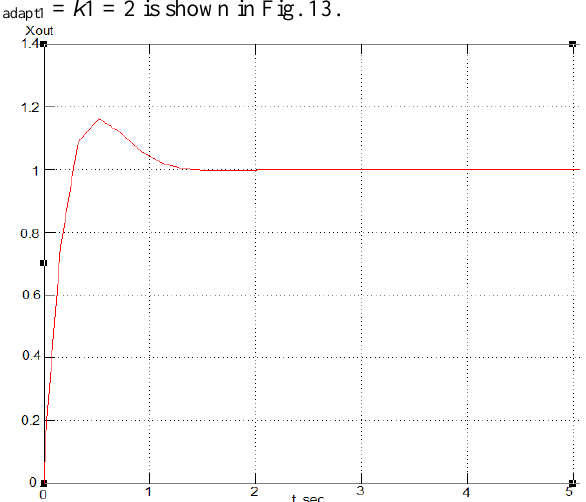
Fig. 13. The curve of control system with F1 = 20 and k 1 = 2.